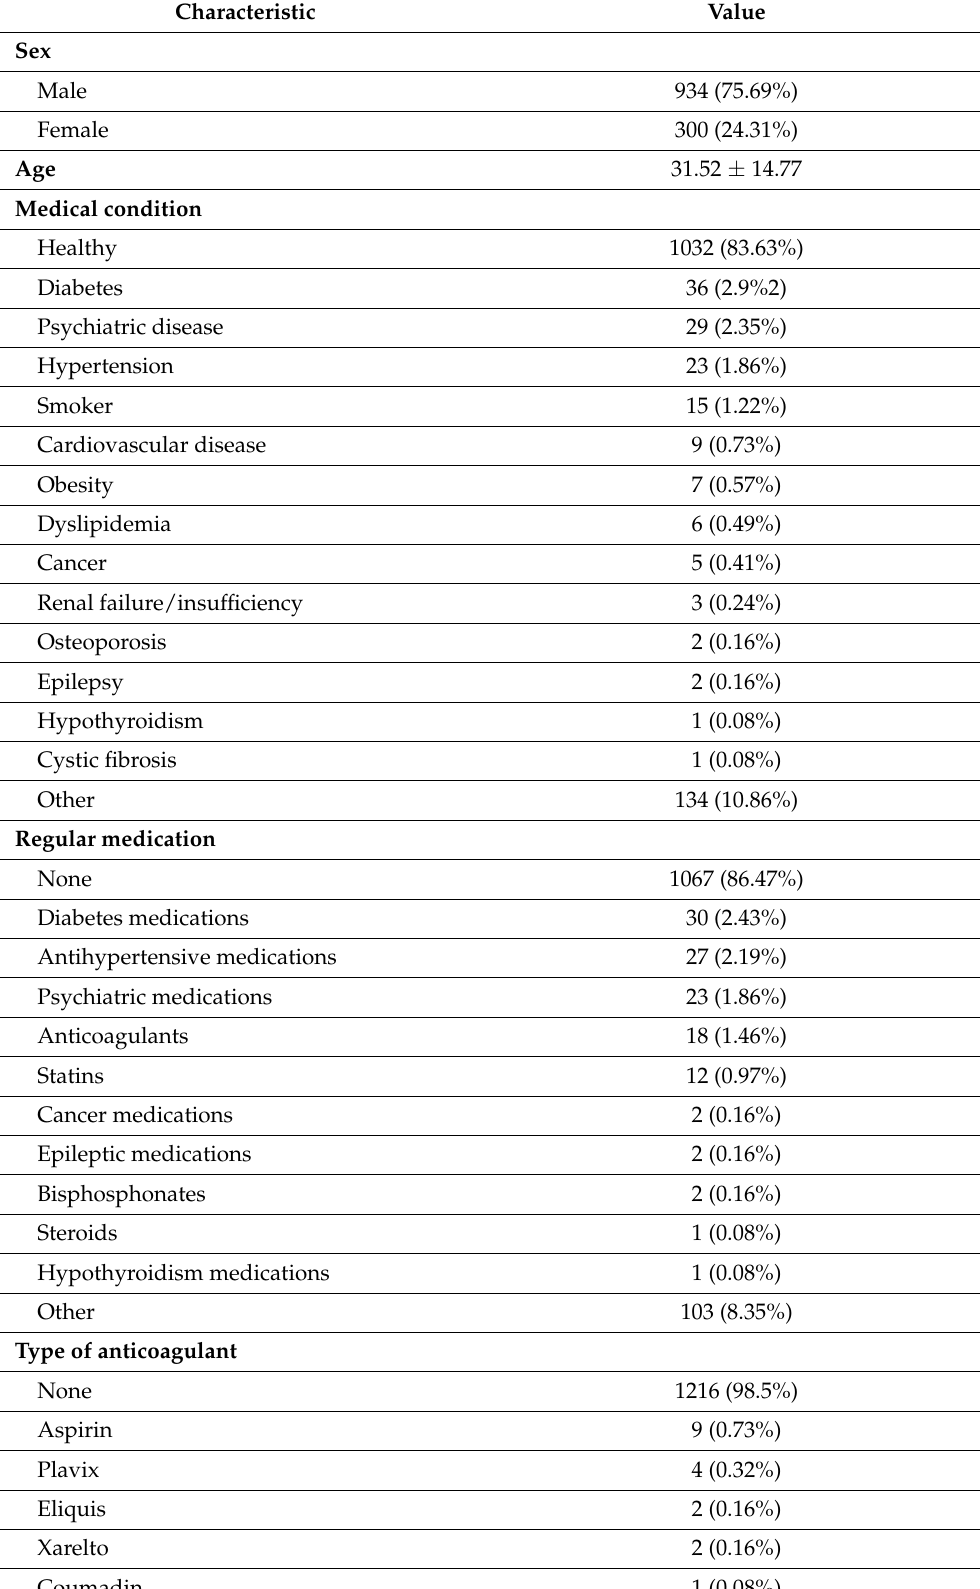
Table 1. Demographic information of 1234 injured riders of E-bikes and